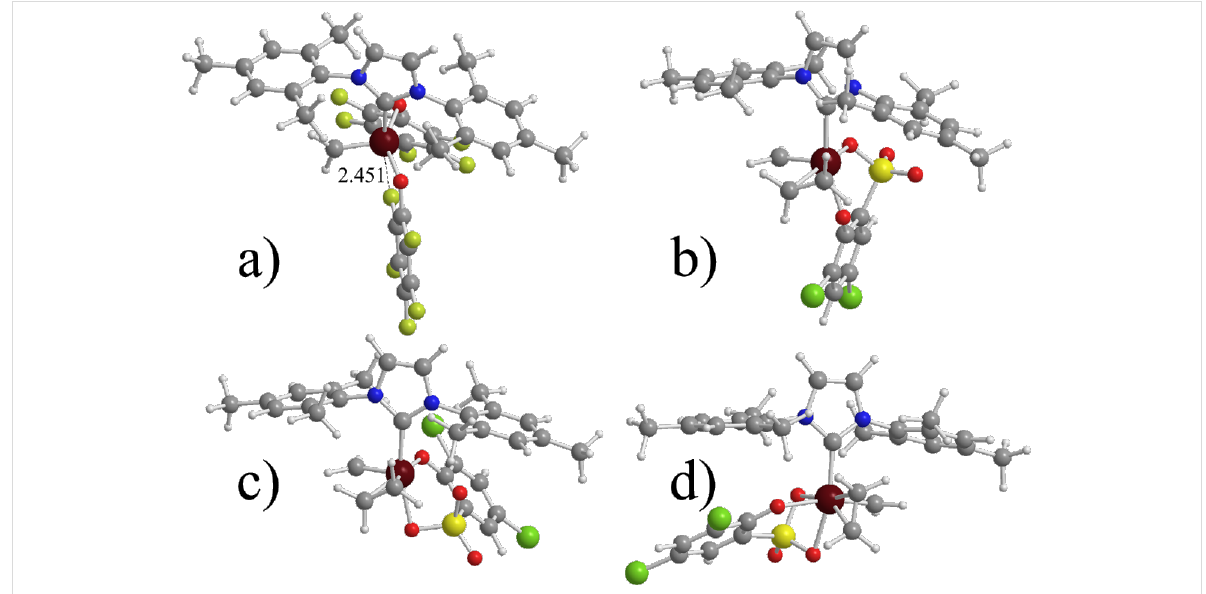
Figure 1: a) Naked 14e species for system 9 (distance in Å). b) trans (T); c) cis(S) (C(S)); and d) cis(O) (C(O)) C 2 H 4 coordinated species for 12 .